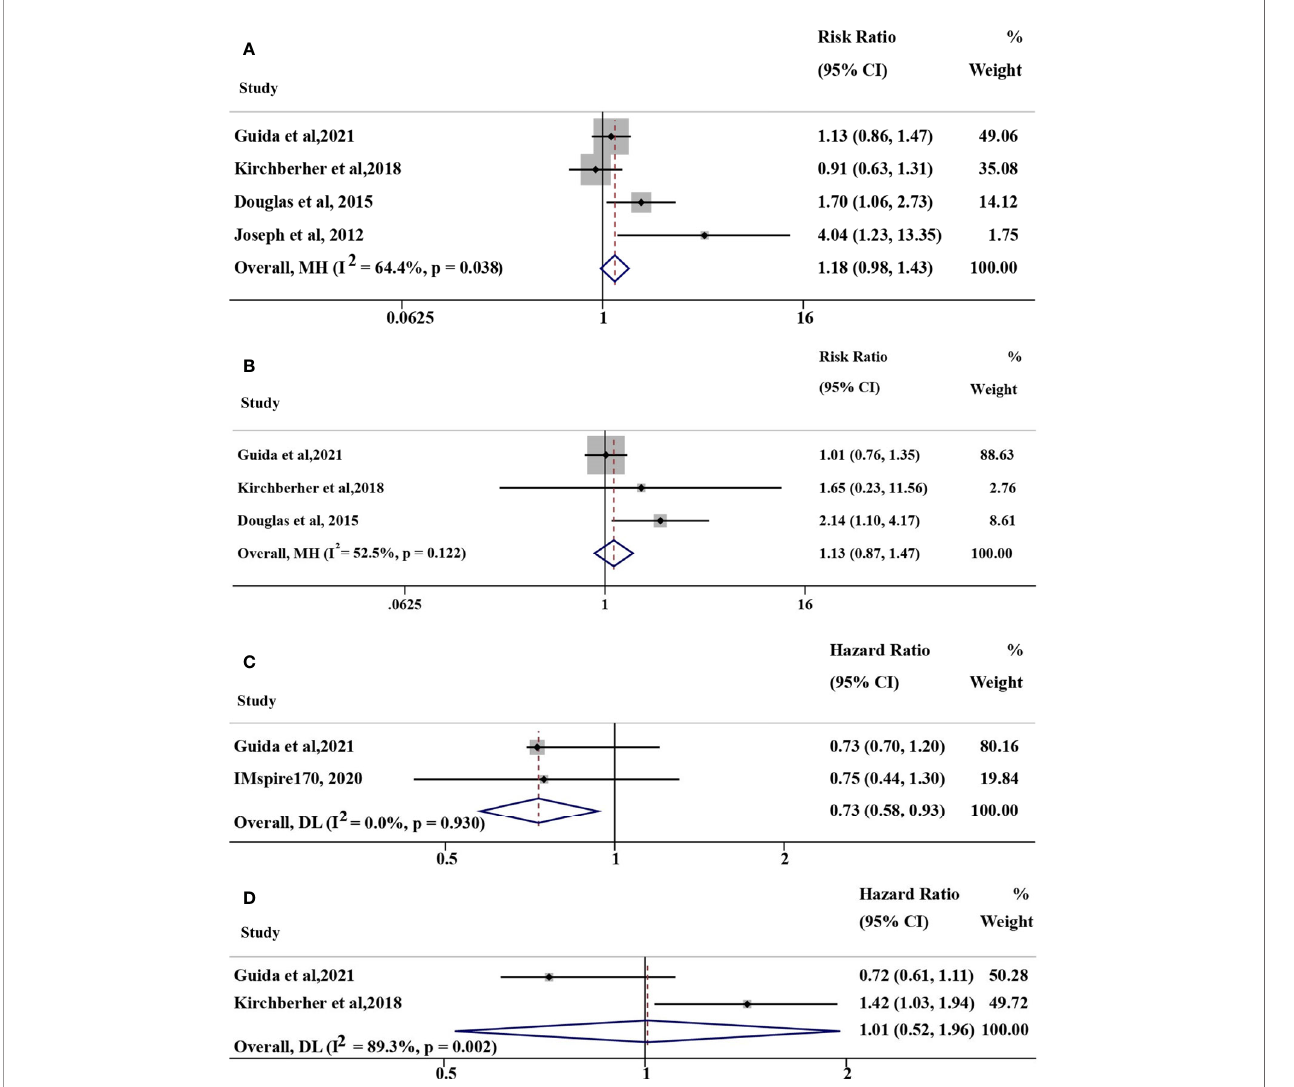
FIGURE 2 | Overall pooled analyses of ef fi cacy for NRAS mutant vs . wild-type (mut/wt) advanced melanoma treated with immunotherapy, including IL-2, anti-PD-(L)1, anti-CTLA-4, and anti-PD-1+anti-CTLA-4 therapy. (A) Risk ration (RR) of ORR for NRAS mut/wt melanoma treated with immunotherapy; (B) RR of ORR for NRAS mut/wt melanoma treated with anti-PD-1 monotherapy; (C) Hazard ratio (HR) of PFS for NRAS mut/wt melanoma treated with immunotherapy; (D) HR of OS for NRAS mut/wt melanoma treated with immunotherapy. I 2 was interpreted by <50% as low heterogeneity; 50% to 75%, moderate heterogeneity; and >75% as high heterogeneity in our